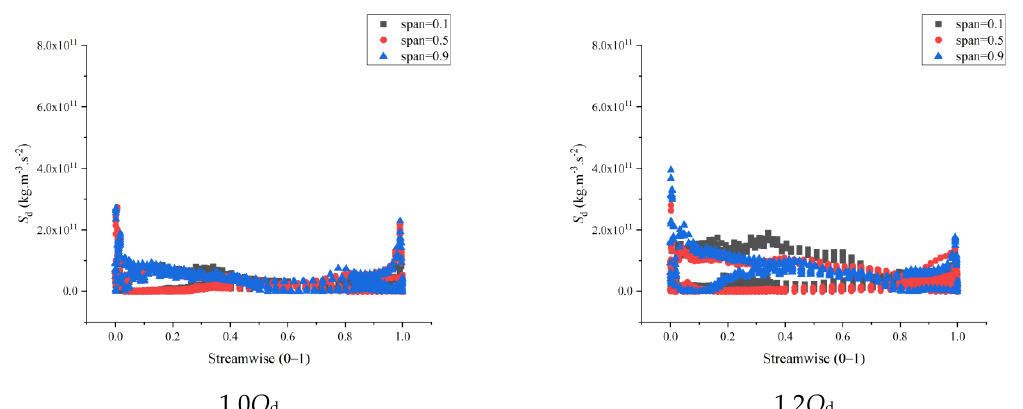
Figure 14. Dipole source distribution on guide vane surface.